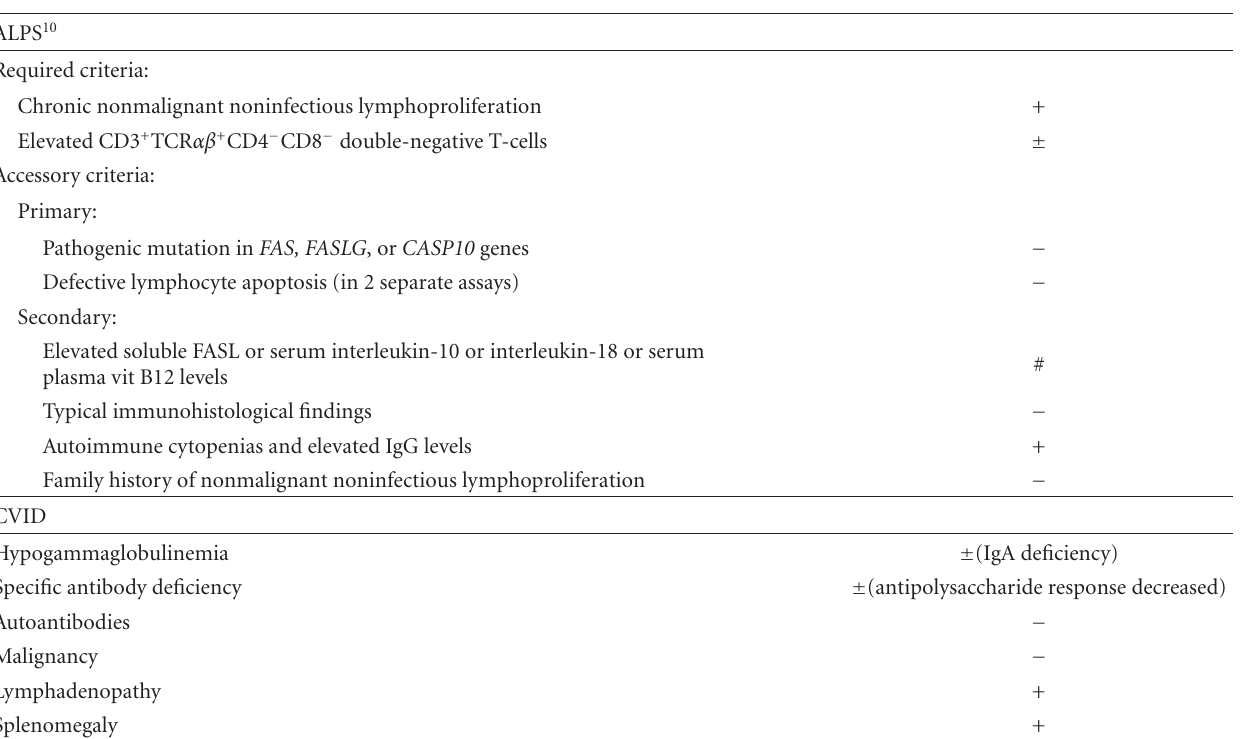
Table 3: Signs of ALPS and CVID definitions in our